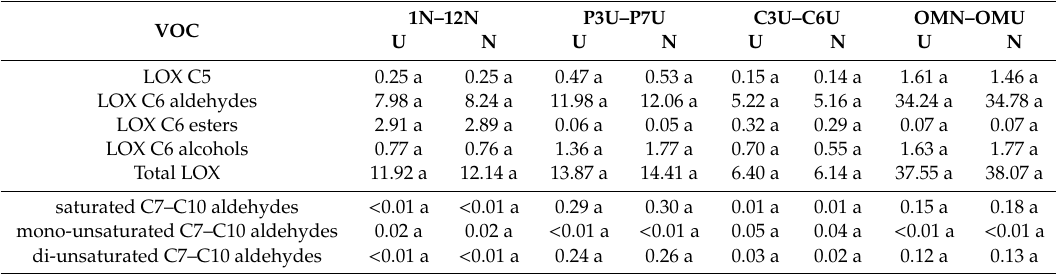
Table 3. Distribution of the different groups of volatiles produced during the lipoxygenase cascade (first 5 rows) and linked to oxidative defects (last 3 rows) in oils obtained with (U) and without (N) the use of SHE. For each couple of oils, no differences were highlighted as indicated by the same letter (a).